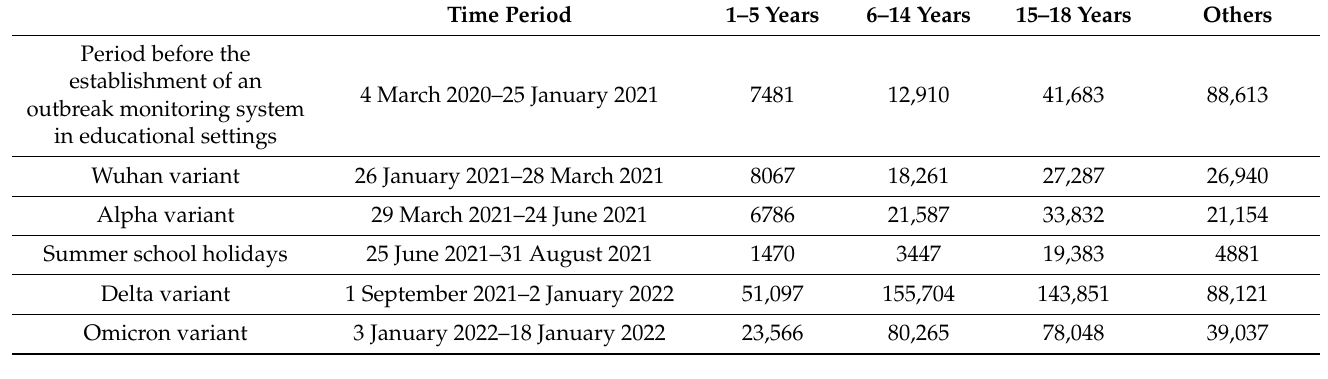
Table 4. Incidence rate of confirmed COVID-19 cases per 100,000 population by age group according to the period of predominance of variant SARS-CoV-2 and the openness of educational settings in Slovenia. Time Period